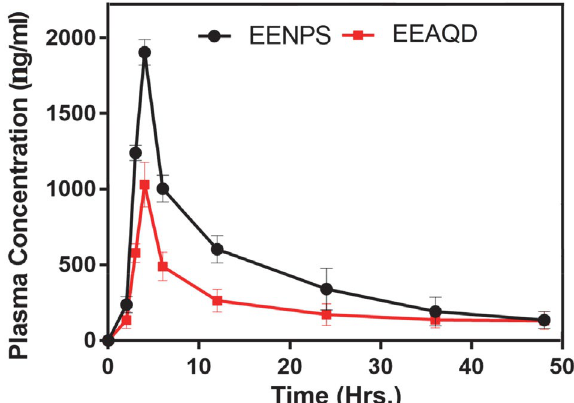
Figure 11. Plasma concentration-time profiles of EE after oral ad- ministration of EENPS and the EEAQD formulation in rats. Each value represents the mean ± S.D. (n =